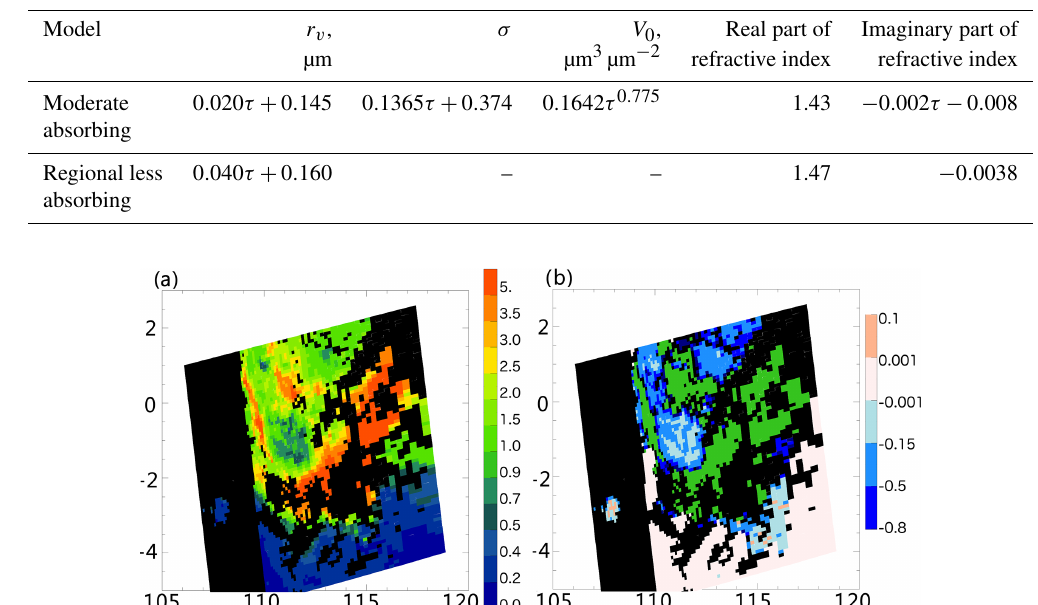
Table 1. Optical properties of the aerosol model used by the operational DT algorithm over the Indonesian region and the regional smoke model (less absorbing model) generated in this study using AERONET inversion products August to October 2015. A dash (–) indicates that